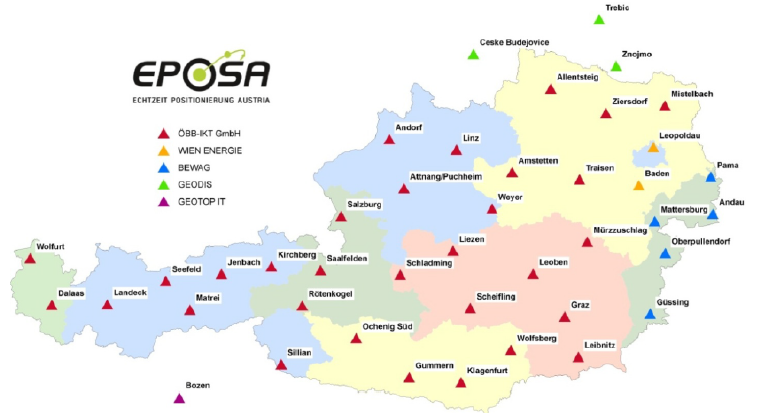
Figure 1. The reference station network of EPOSA. The colour of the triangles denotes the company operating the station. Taken from http://www.eposa.at/, accessed on 15 April